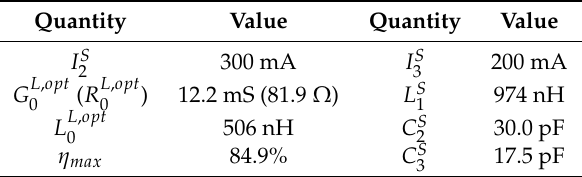
Table 4. Calculated values for the maximum efficiency solution.